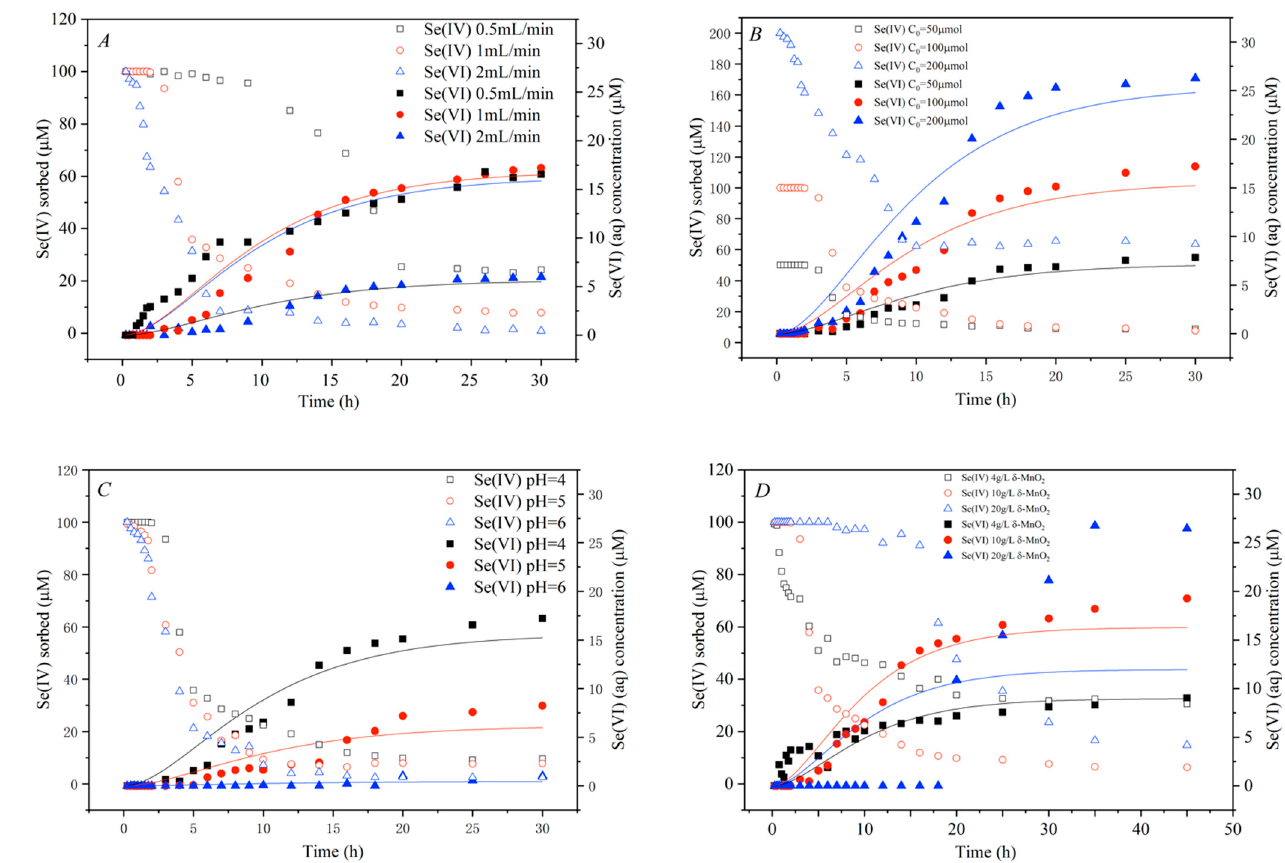
Figure 2. The amount of Se(IV) adsorbed and Se(VI) in the effluent, as well as oxidation kinetics of a stirred-flow experiment reacting at the flow rate of ( A ) 0.5, 1, and 2 mL L − 1 of ( B ) 50, 100, and 200 µ mol L − 1 Se(IV) (C 0 ) with ( C ) a pH 4, 5, and 6, and with ( D ) 4, 10, and 20 g L − 1 δ -MnO 2 . Symbols are experimental data, and lines are model calculations.